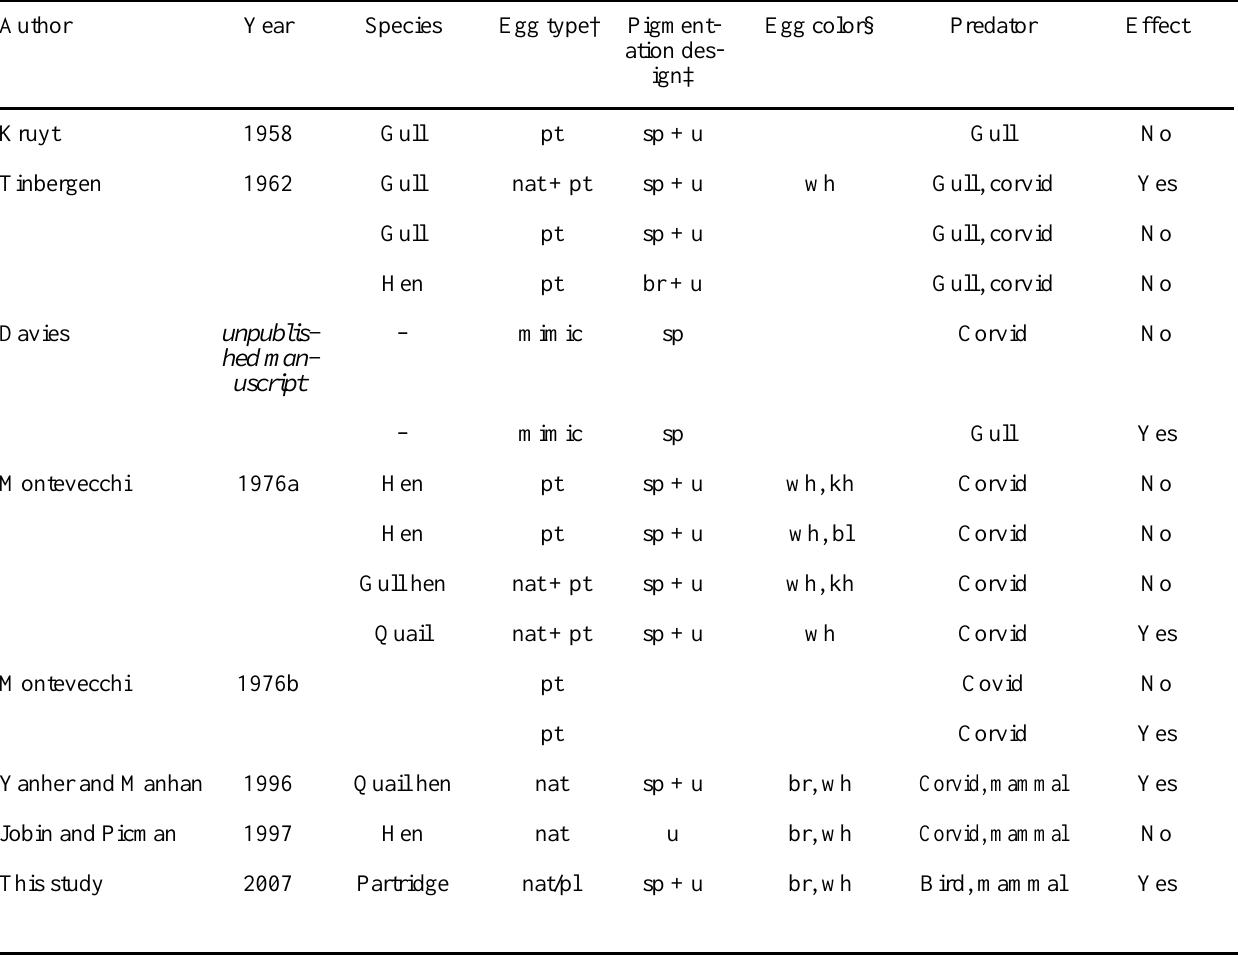
Table 1. Results of studies examining the effect of egg pigmentation on nest predation.